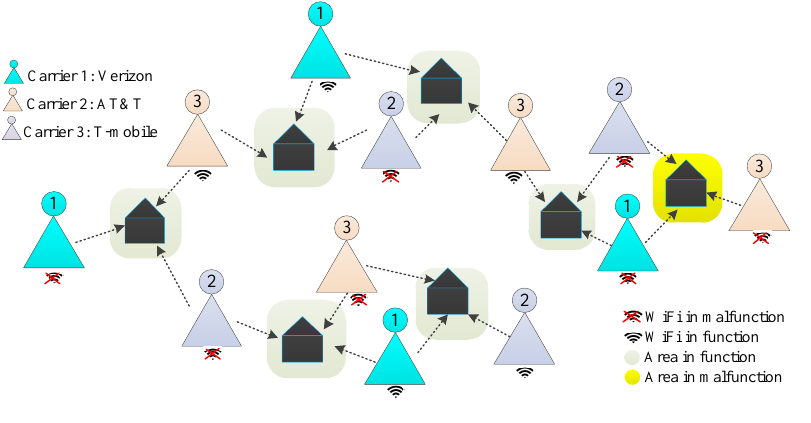
Figure 1. A Wi-Fi system.